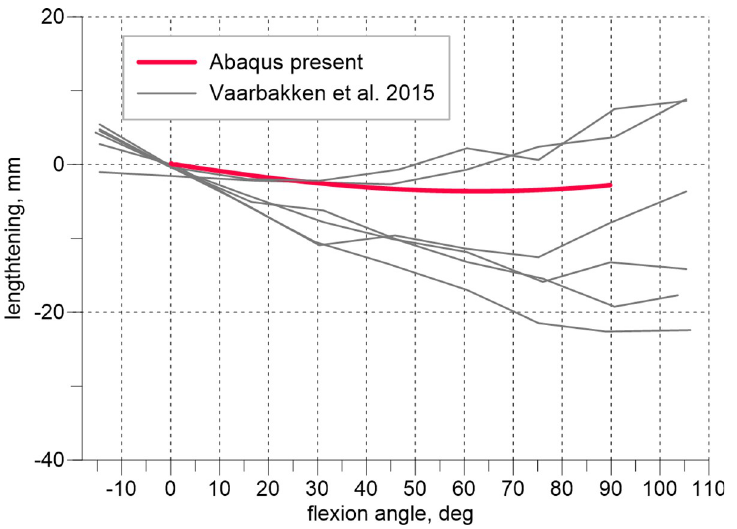
Fig 6. Lengthening of the obturator externus vs. hip flexion